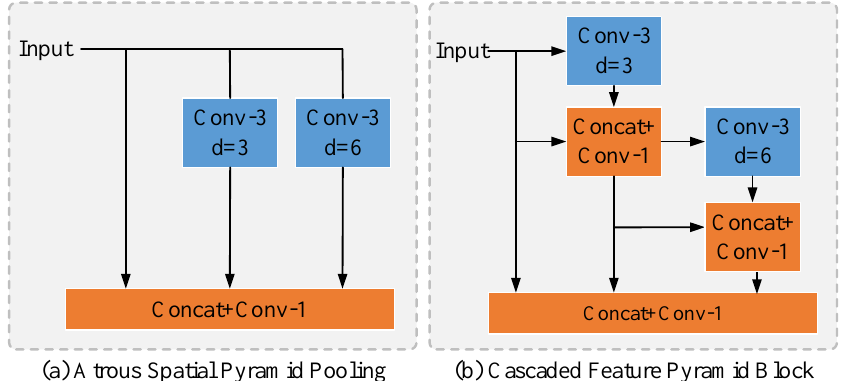
Figure 4. CFPB ( b ) is an improment of ASPP ( a